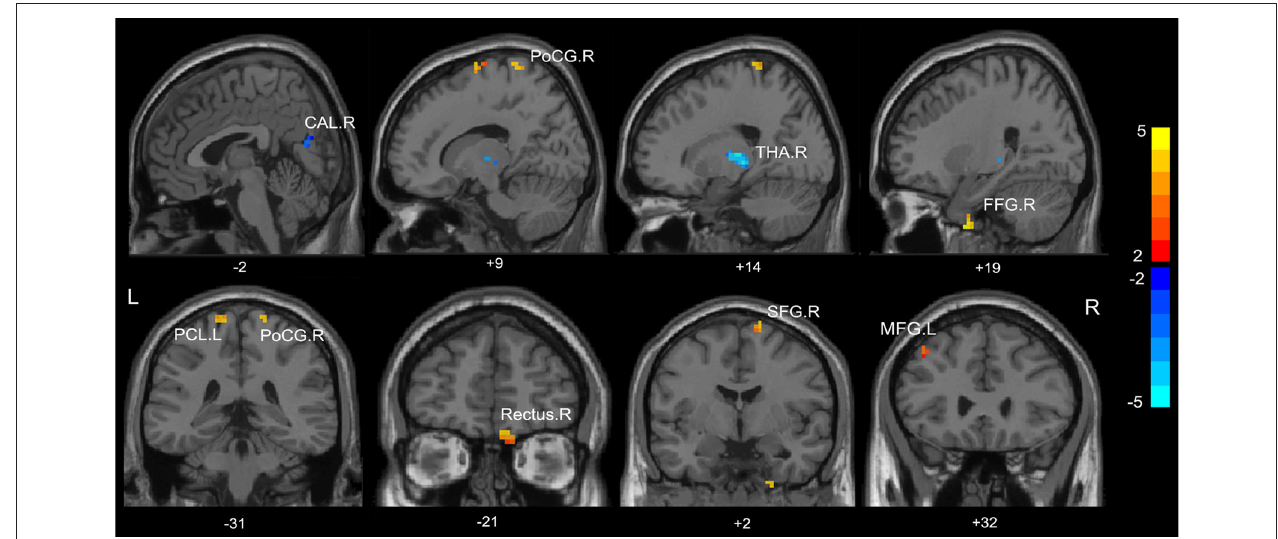
FIGURE 2 | Group differences of mean ReHo between patients with minimal hepatic encephalopathy (MHE) and healthy controls ( p < 0.05, FDR corrected). FFG, fusiform gyrus; PoCG, postcentral gyrus; THA, thalamus; CAL, calcarine; THA, thalamus; SFG, superior frontal gyrus; PCL, paracentral lobule; MFG, middle frontal gyrus; R, Right; L, Left. The color bar indicates a scale of T values.